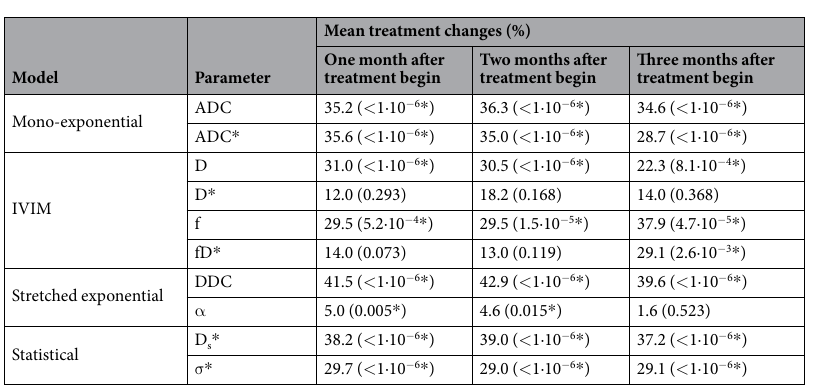
Table 2. Percentage changes of the various diffusion parameters observed one, two, and three months after treatment begin. The values in parentheses are the p-values of the post-hoc comparisons of the baseline values with those one, two, and three months after anticancer treatment. Significant statistics have p < 0.017, incorporating a correction for multiple comparisons. Statistically significant values are designated by an